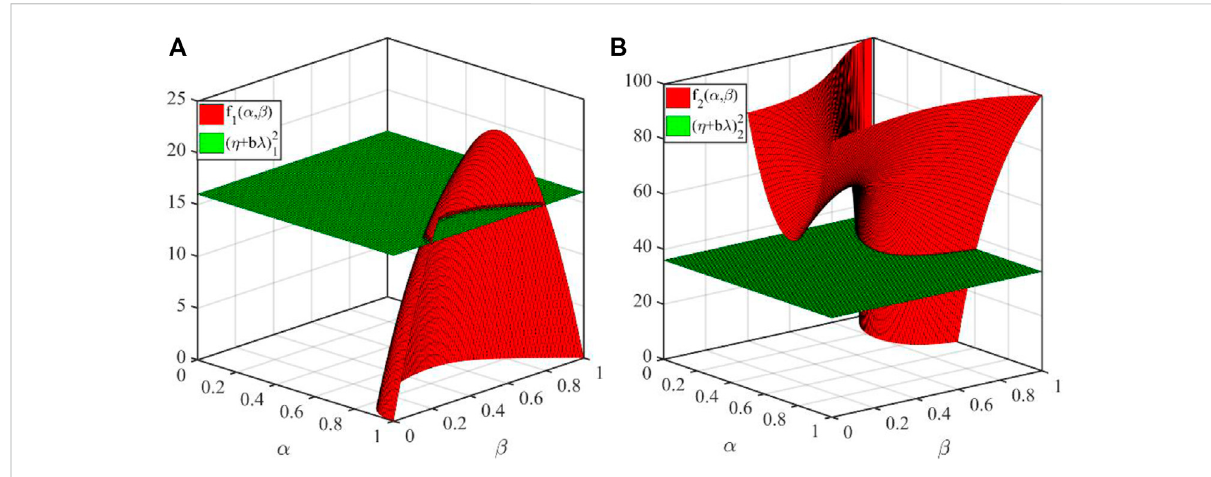
FIGURE 11 Impact of cross-shareholding ratio on coordination effect. (A) Horizontal surface ( η + b λ ) 2 (cid:2) 16. (B) Horizontal surface ( η + b λ ) 2 (cid:2)